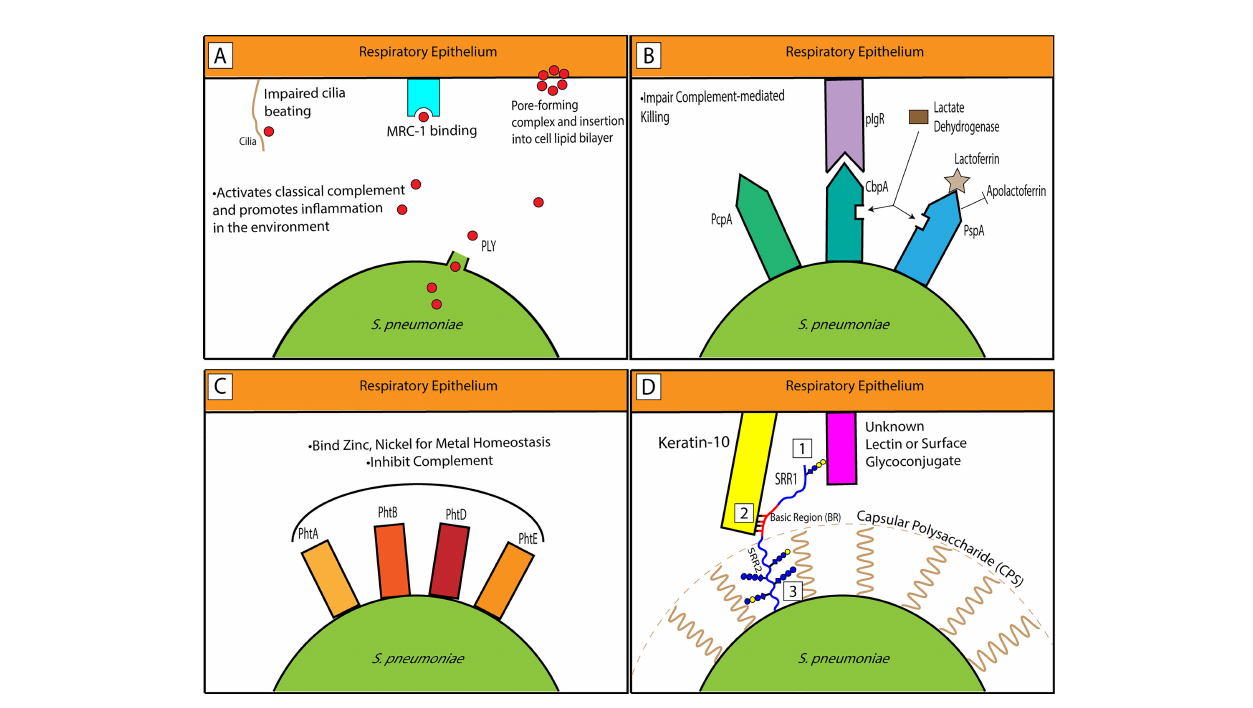
FIGURE 1 | Interactions of pneumococcal factors representative of classes within the host respiratory epithelium. (A) PLY is released from Spn . It is pro- in fl ammatory in the environment and PLY monomers aggregate to form ring complexes that can trigger host cell death. It can interact with MRC-1 to promote bacterial survival. (B) CBPs impair complement-mediated killing by the host. PcpA in fl uences bio fi lm formation and pneumococcal adhesion. CbpA binds its main receptor, pIgR, to promote adherence. PspA binds lactoferrin for critical iron uptake for the bacterium from the host and inhibits apolactoferrin. Both CbpA and PspA can bind lactate dehydrogenase to enhance virulence. (C) The PHTs are well-conserved surface proteins on the pneumococcus and maintain metal homeostasis through Zn and Ni binding. (D) A model showing PsrP ’ s SRR1-BR region extending past the CPS. While the SRR1 glycans potentially interact with another host ligand (1), the basic region binds Keratin-10 (2). Alternatively, as previously hypothesized, the glycans may be employed as important interactors with the CPS to hoist PsrP up so that it can extend past the capsule